Question: Generate an informative caption for the figure above.
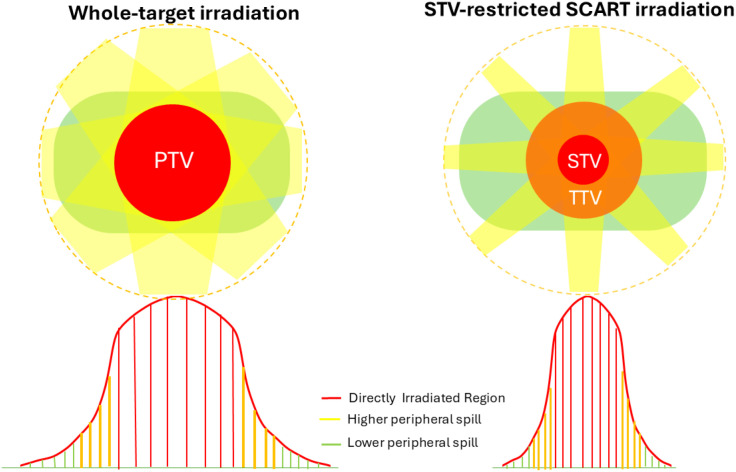
Answer: STV-restricted stereotactic delivery and peripheral sparing. In whole-target irradiation strategies, beam apertures conform to the outer target extent, producing high-dose regions that approach the tumor boundary. In SCART, apertures are confined to the central STV, so dose spill traverses tumor tissue before reaching the periphery. This inward displacement of the high-dose region preserves a lower-dose peripheral rim and reduces extension of ablative dose into adjacent normal tissue.